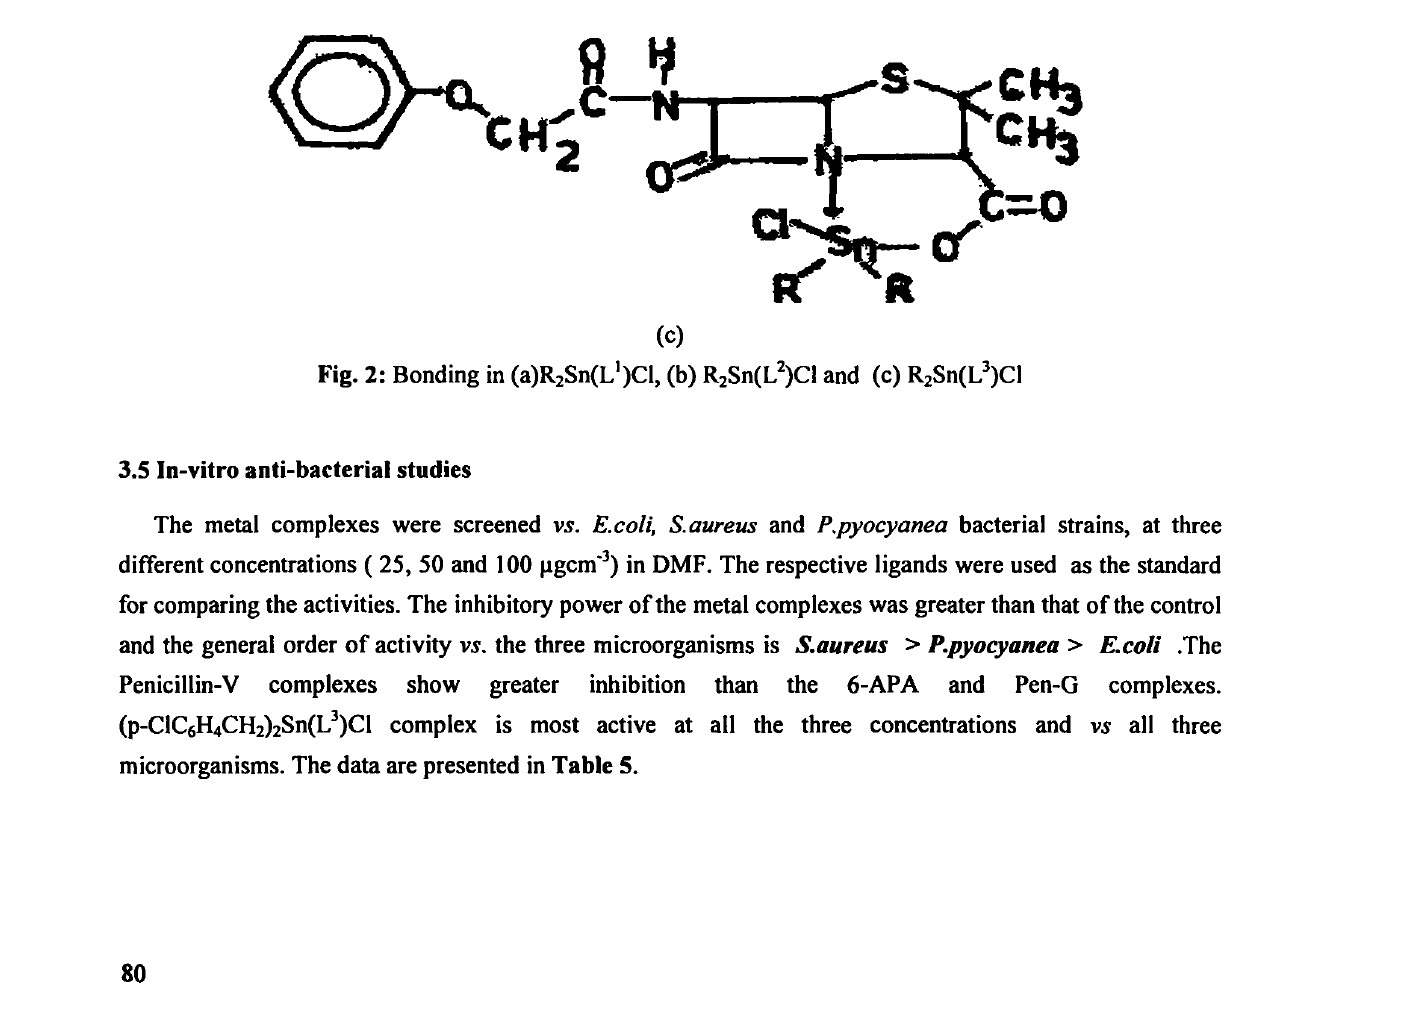
Sn(L 2 )Cl and (c) R 2